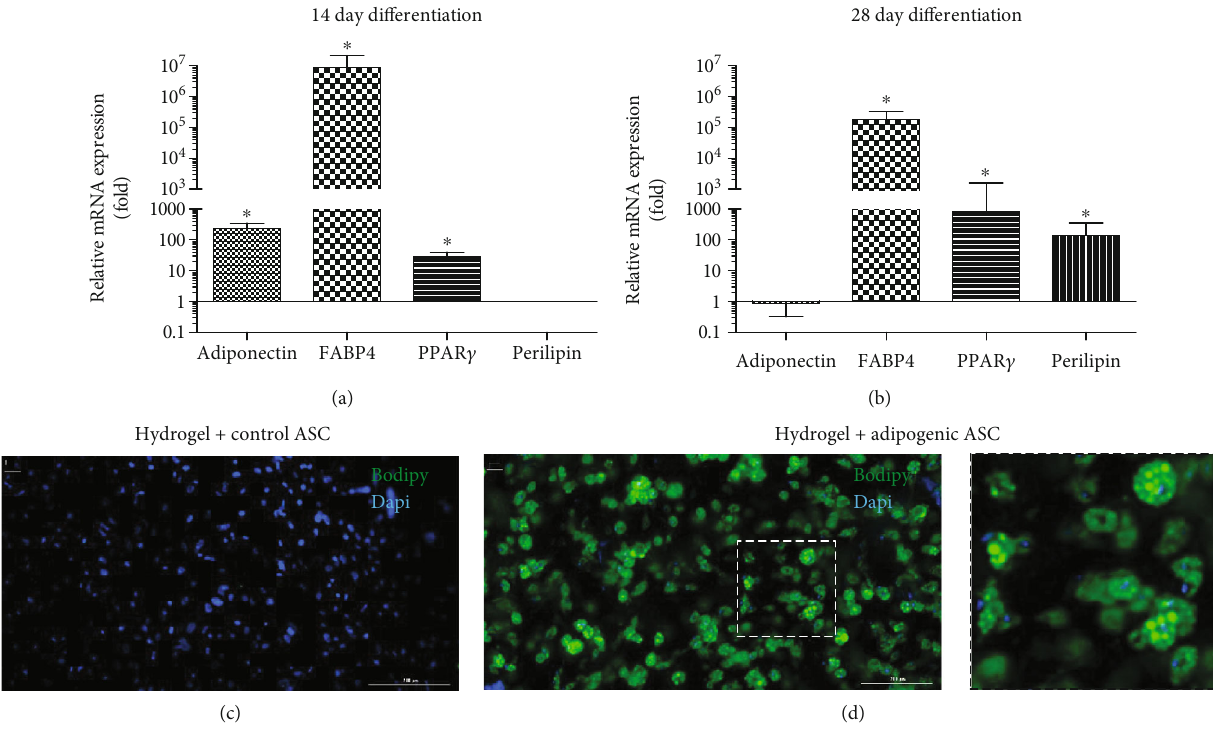
Figure 3: Analysis of adipogenic di ff erentiation of ASCs in DAT hydrogel. ASC seeded DAT hydrogels (2 × 10 6 cells/mL) were cultured in stromal or adipogenic media for 14 or 28 days and analyzed by qRT-PCR (a, b) and BODIPY staining (c, d). (a, b) Expression of adipogenic genes in adipogenically induced ASC samples after 14 (a) or 28 days (b) of culture is displayed as fold change relative to the control ASC samples. (c, d) Representative images of BODIPY/DAPI staining of 28-day Control ASC (c) and adipogenic ASC (d) seeded DAT hydrogels. Data are expressed as mean ( n = 6 ) ± SD; level of signi fi cance: ( ∗ ) p < 0 : 05 ; Scale bar 200 μ